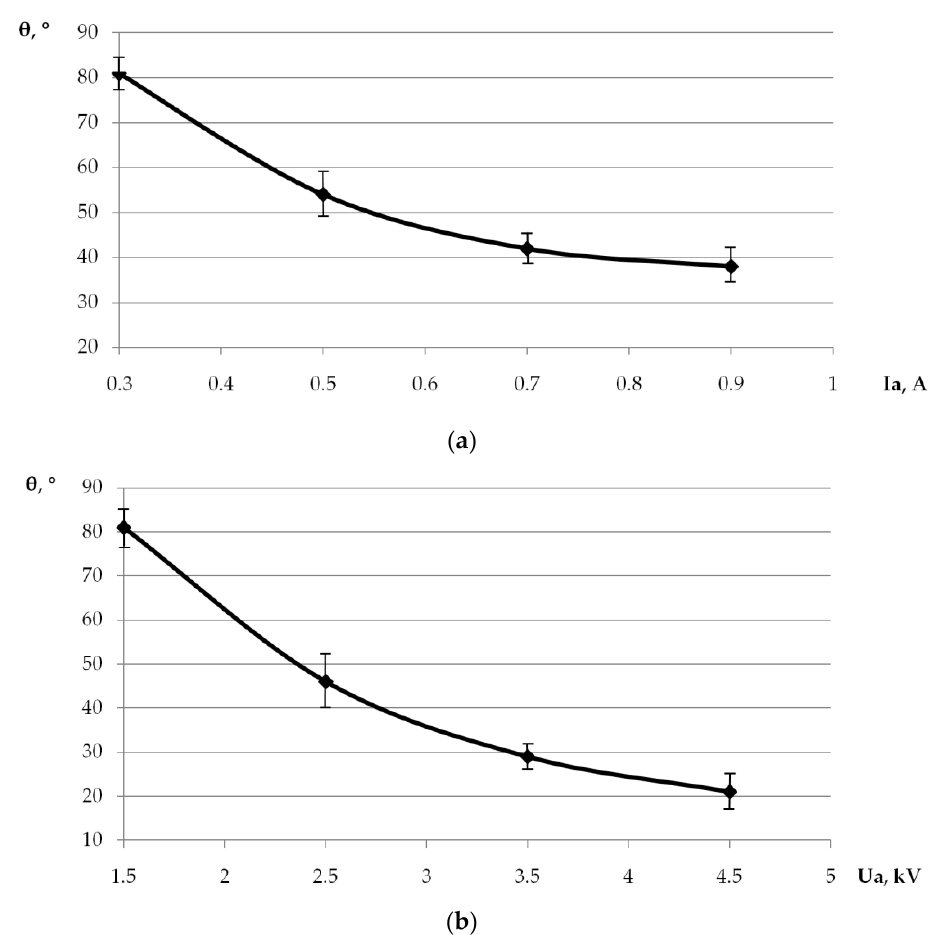
Figure 7. Dependence of the marginal wetting angle of wood samples treated with low-pressure RF plasma on ( a ) anode voltage at the (Ua, kV); and ( b ) anode current (Ia, A).